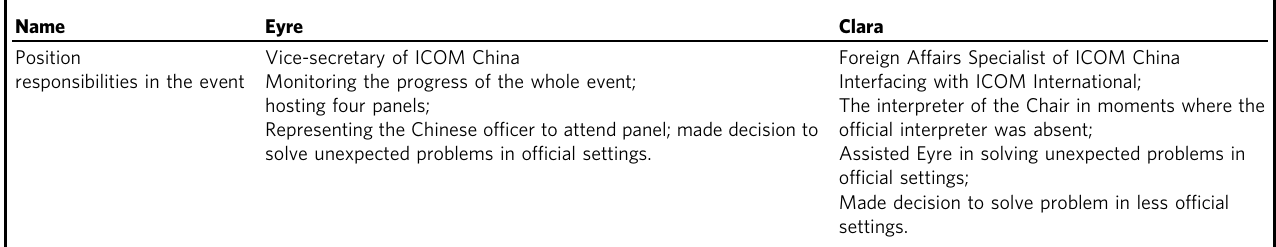
Table 4 Two language brokers ’ responsibilities.